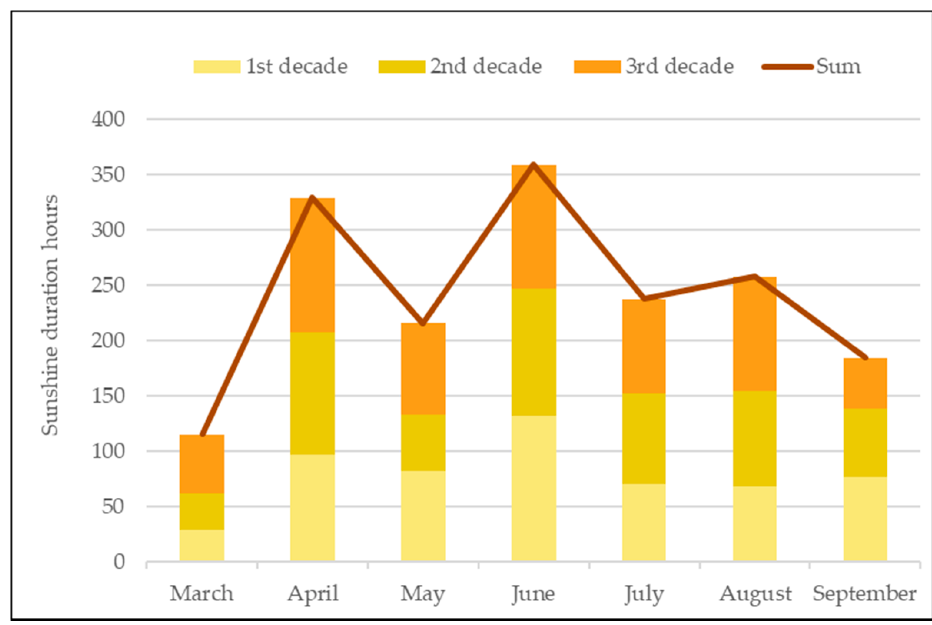
Figure 2. Sunshine duration in nettle growing period (Kaunas meteorological station).